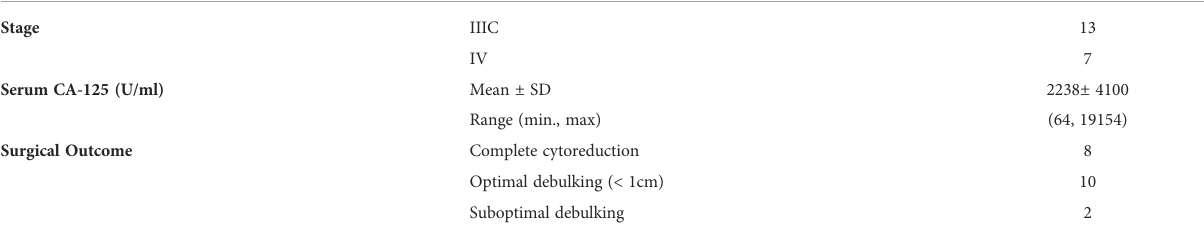
TABLE 1 Summary of clinical